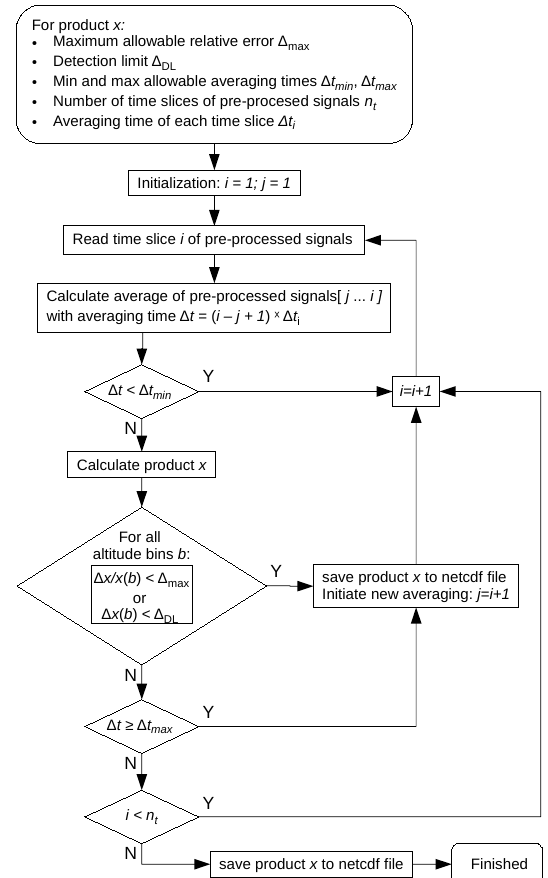
Figure 5. Work flow diagram of the automatic algorithm for tem- poral averaging implemented in